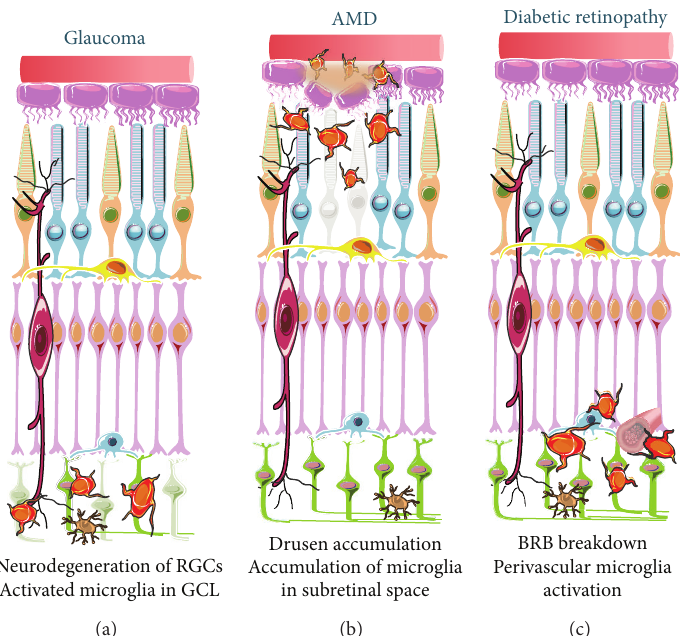
Figure 2: Schematic representation of microglial responses in glaucoma, AMD, and diabetic retinopathy. Reactive microglial cells are found in the retina of patients and animal models of glaucoma (a), AMD (b), and diabetic retinopathy (c). (a) Glaucomatous retinas present abnormally distributed activated microglial cells in the GCL, namely, surrounding the RGC axons and soma. (b) In AMD retinas, microglial cells accumulate in the ONL and subretinal space, surrounding drusen deposits. (c) Increased vascular permeability in diabetic retinopathy is accompanied by perivascular accumulation of activated microglial